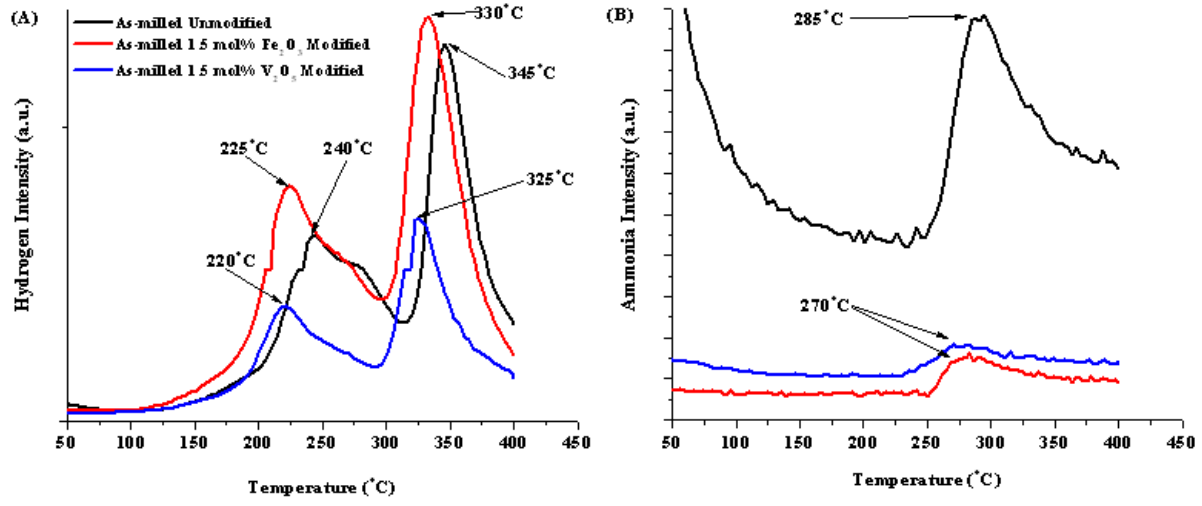
O (red) and V O (blue) 2 3 2 5